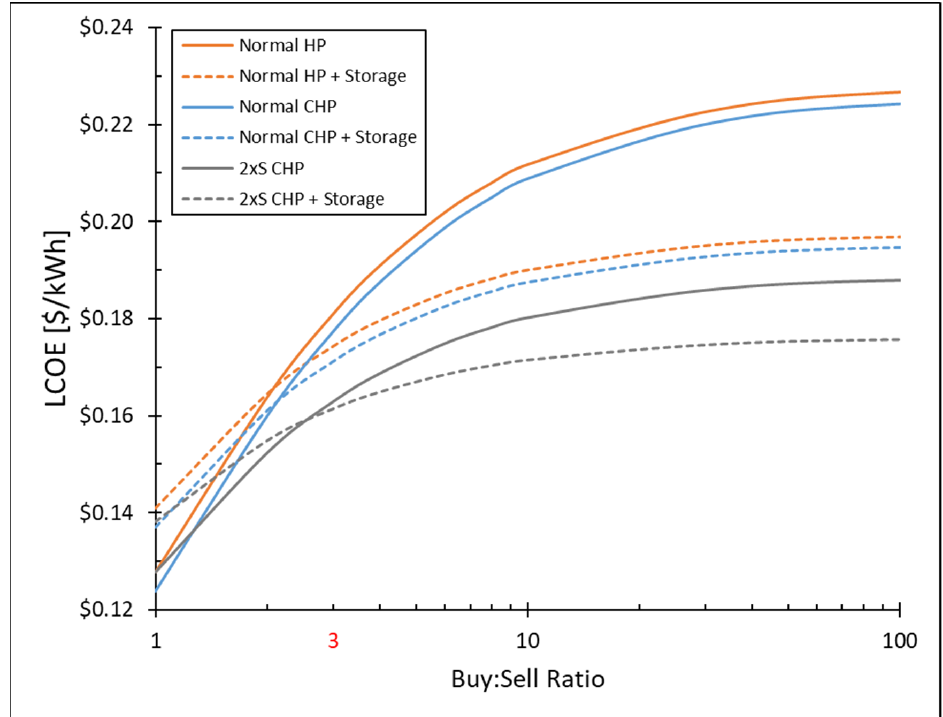
Figure 8. Levelized Cost of Electricity (LCOE) with and with without storage. Only net-zero energy scenarios are plotted. A buy:sell ratio of 1 is net metering where the results cluster with their minimum LCOE near 0.14 $/kWh and 0.13 $/kWh with and without storage, respectively. As the buy:sell ratio increases, scenarios with storage achieve a lower LCOE. The cross-over buy:sell ratio is between 1 and 2 for the normal load profiles, and just over 2 for the 2 × Summer (2 × S) CHP net-zero energy strategies. A nominal buy:sell ratio of 3 was assumed in this analysis based on a comparison of wholesale and retail electricity prices [51,52].